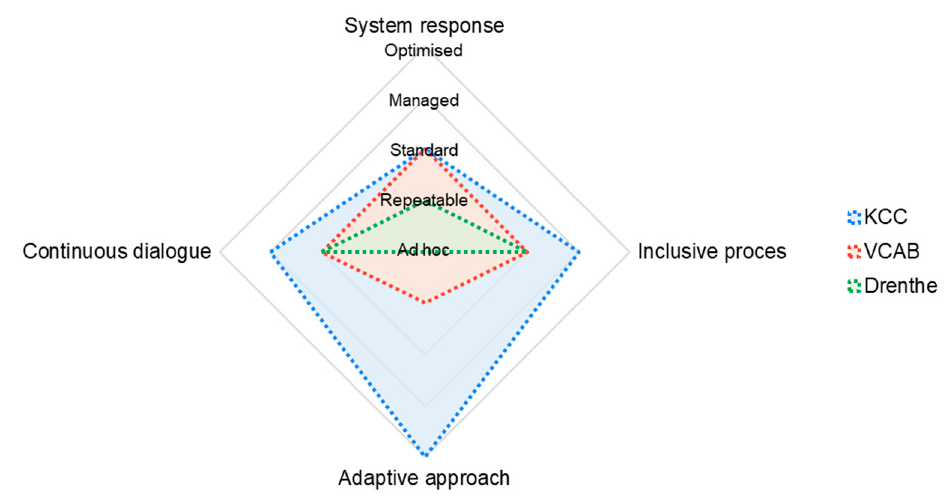
Figure 4. Spider diagrams of maturity of national and state governmental authorities.